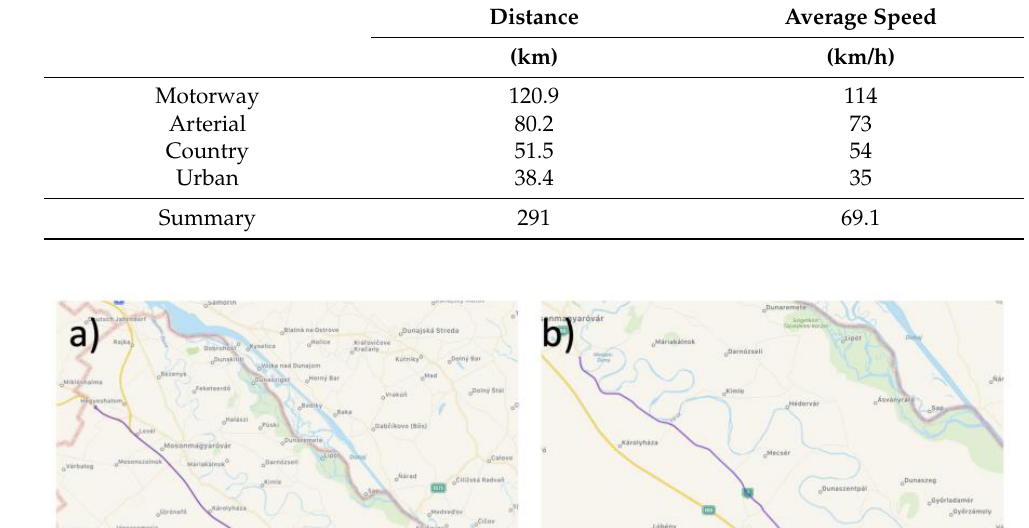
Table 2. Specifications of routes and vehicle speeds for the van used in this study.